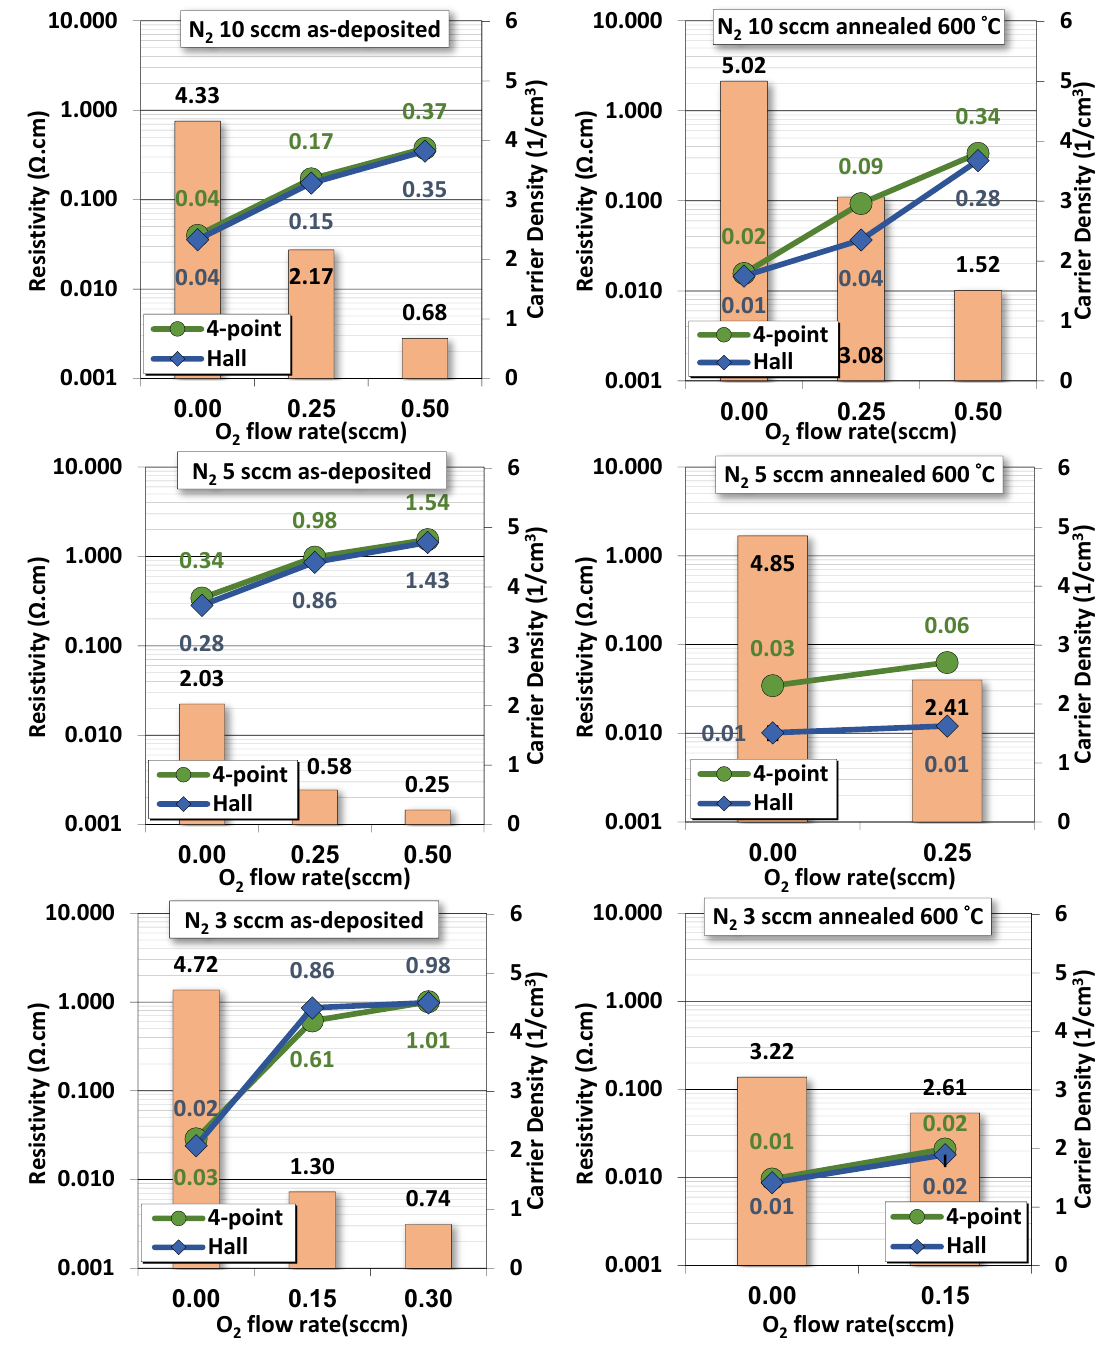
Figure 6. Electrical resistivity and carrier density of as-deposited and annealed films under 600 °C for nitrogen flow rates 3, 5, and 10 sccm.